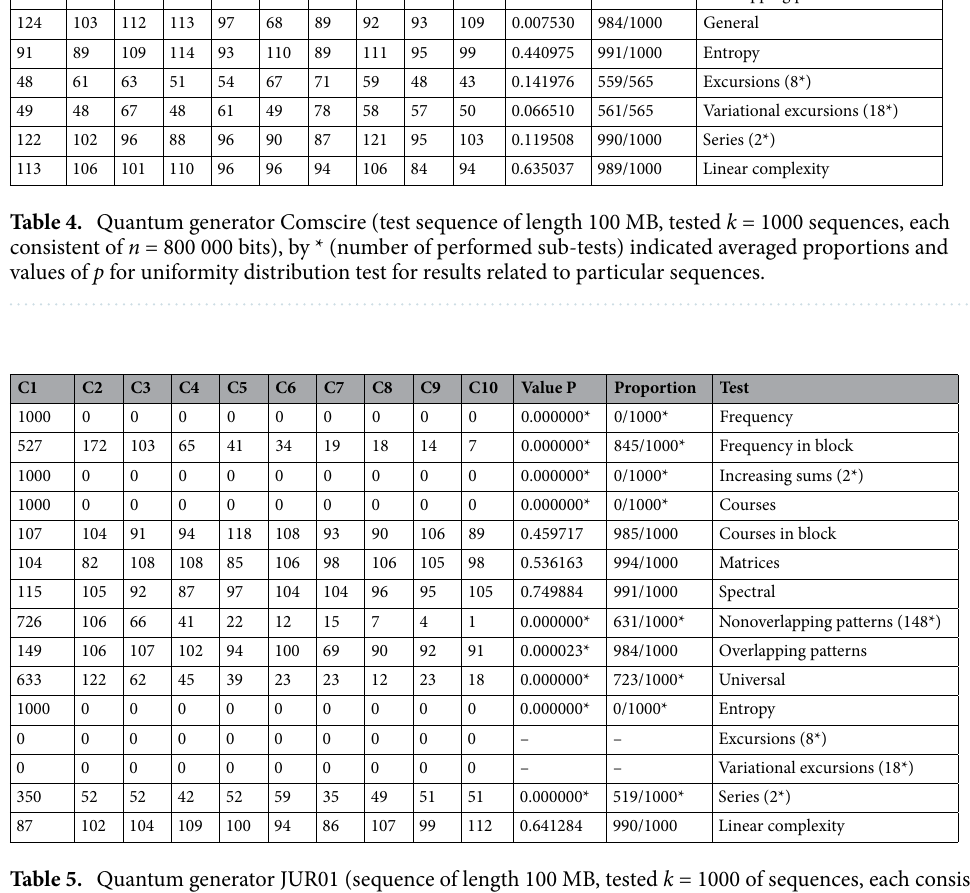
Table 5. Quantum generator JUR01 (sequence of length 100 MB, tested k = 1000 of sequences, each consistent of n = 800 000 bits).